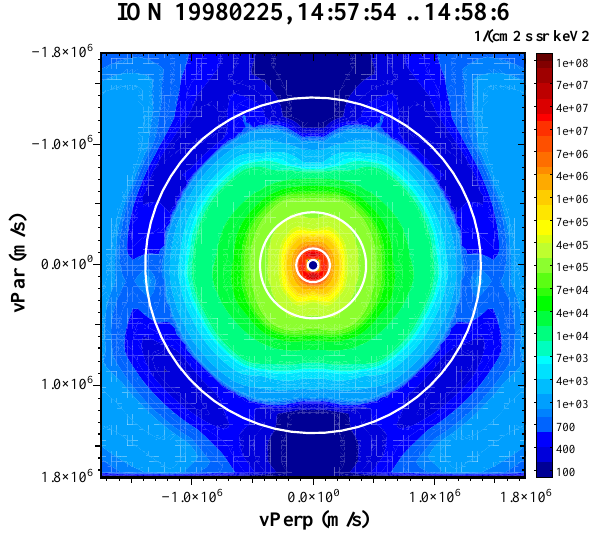
Fig. 2. Example of a CPS ion shell distribution. The quantity shown is the distribution function in units of cm − 2 s − 1 sr − 1 keV − 2 . Up- going ions go up and downgoing ions go down in the plot. White circles correspond to energies 10eV, 100eV, 1keV and 10keV. The shell distribution starts at ∼ 15keV and partly falls outside the plot and instrument boundaries in this case. One-count level is 20 times smaller than the shell distribution level, MLT 2, ILAT 67, R = 4 . 4 R E , n = 0 . 66cm − 3 , T = 1 . 9keV, free energy density 0.15keVcm − 3 .